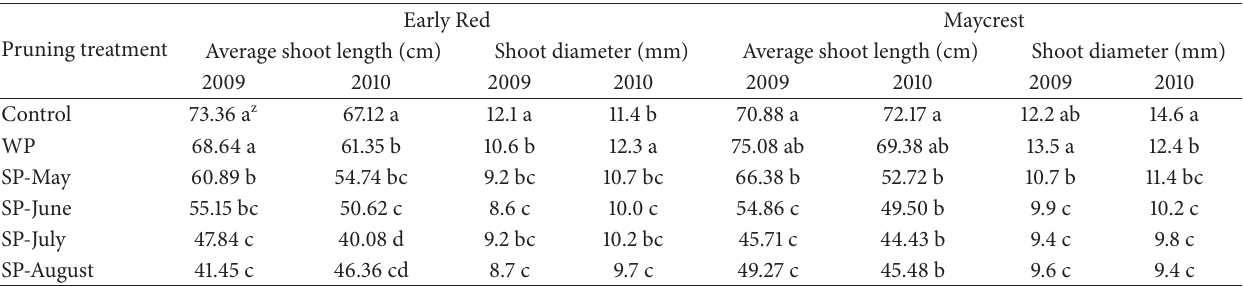
Table 1: The influence of summer and winter pruning treatments on average shoot length and shoot diameter. Pruning